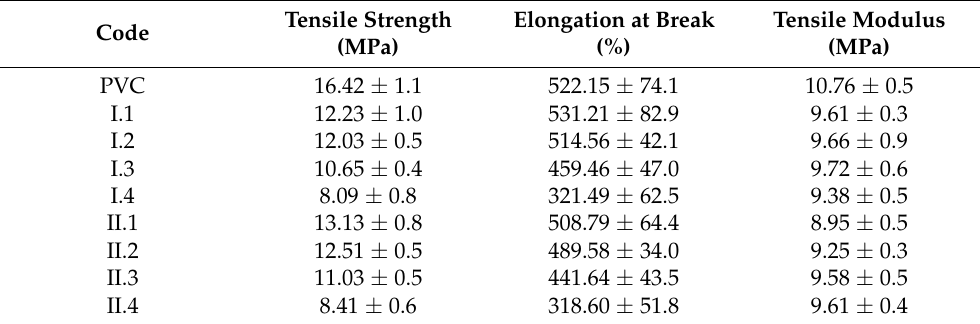
Table 8. Tensile strength, tensile modulus and elongation at break of PVC and all PVC composites.